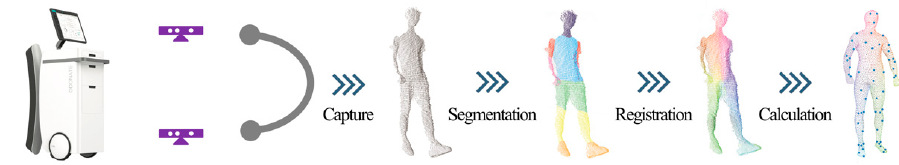
Figure 1. The analysis process of Odonate 3D motion capture system.